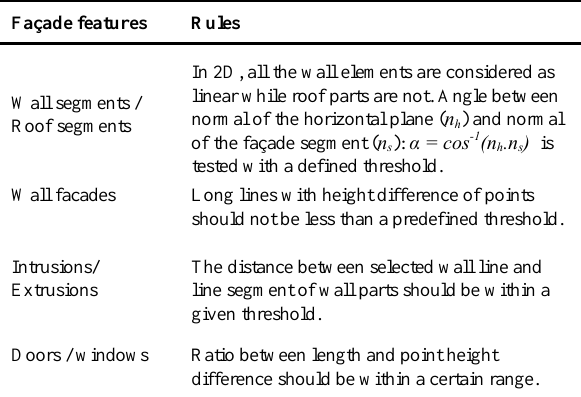
Table 1: Rules for recognizing façade features in 2D